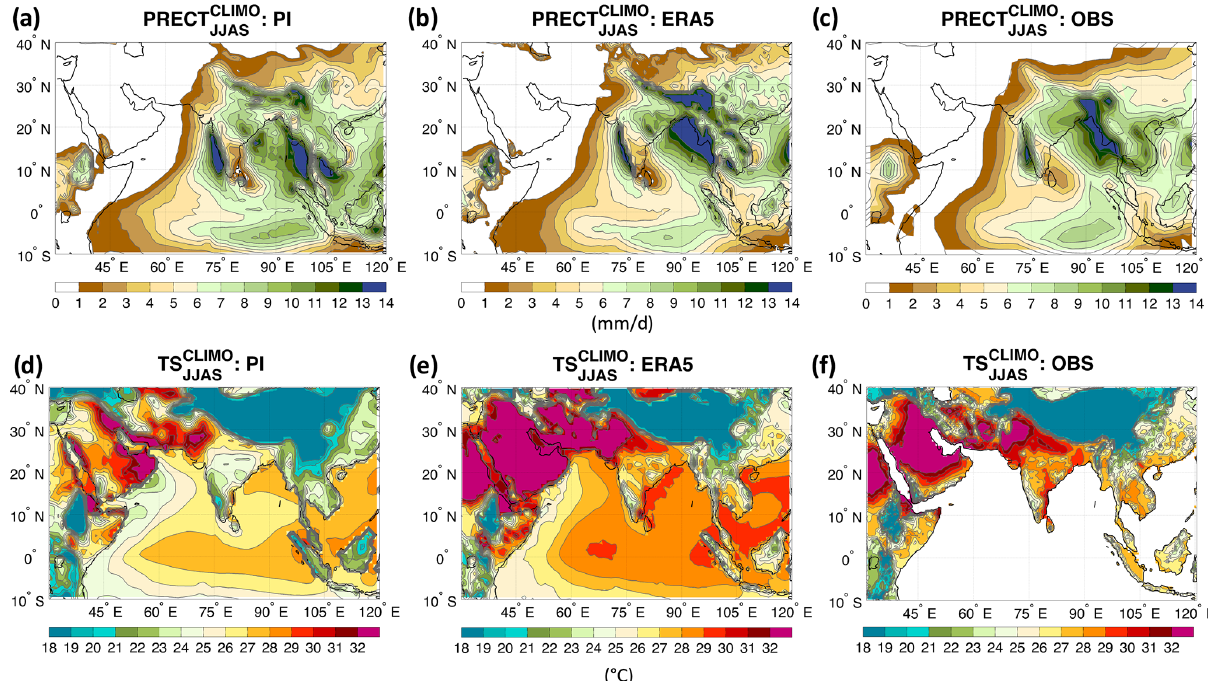
Figure A1. Climatological summer (JJAS) precipitation (PRECT; mm/d) from (a) the PI simulation, (b) the ERA5 reanalysis for the period 1979–2018, and (c) the Global Precipitation Climatology Project (GPCP) version 2.3 for the period 1979–2018. Climatological summer (JJAS) surface temperature (TS; ◦ C) from (d) the PI and (e) the ERA5 reanalysis for the period 1979–2018; and (f) near-surface temperature from the Climatic Research Unit (CRU) time series version 4.04 for the period 1979–2018.